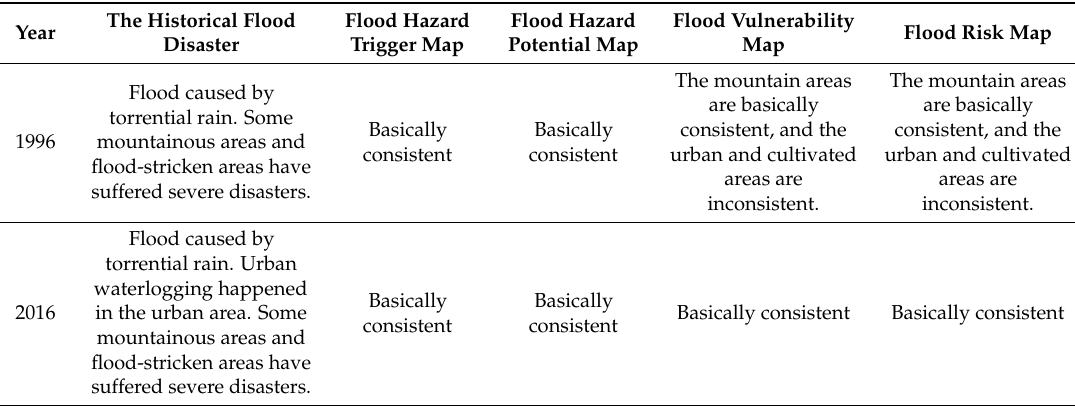
Table 5. Historical records of flood disaster in Shijiazhuang since